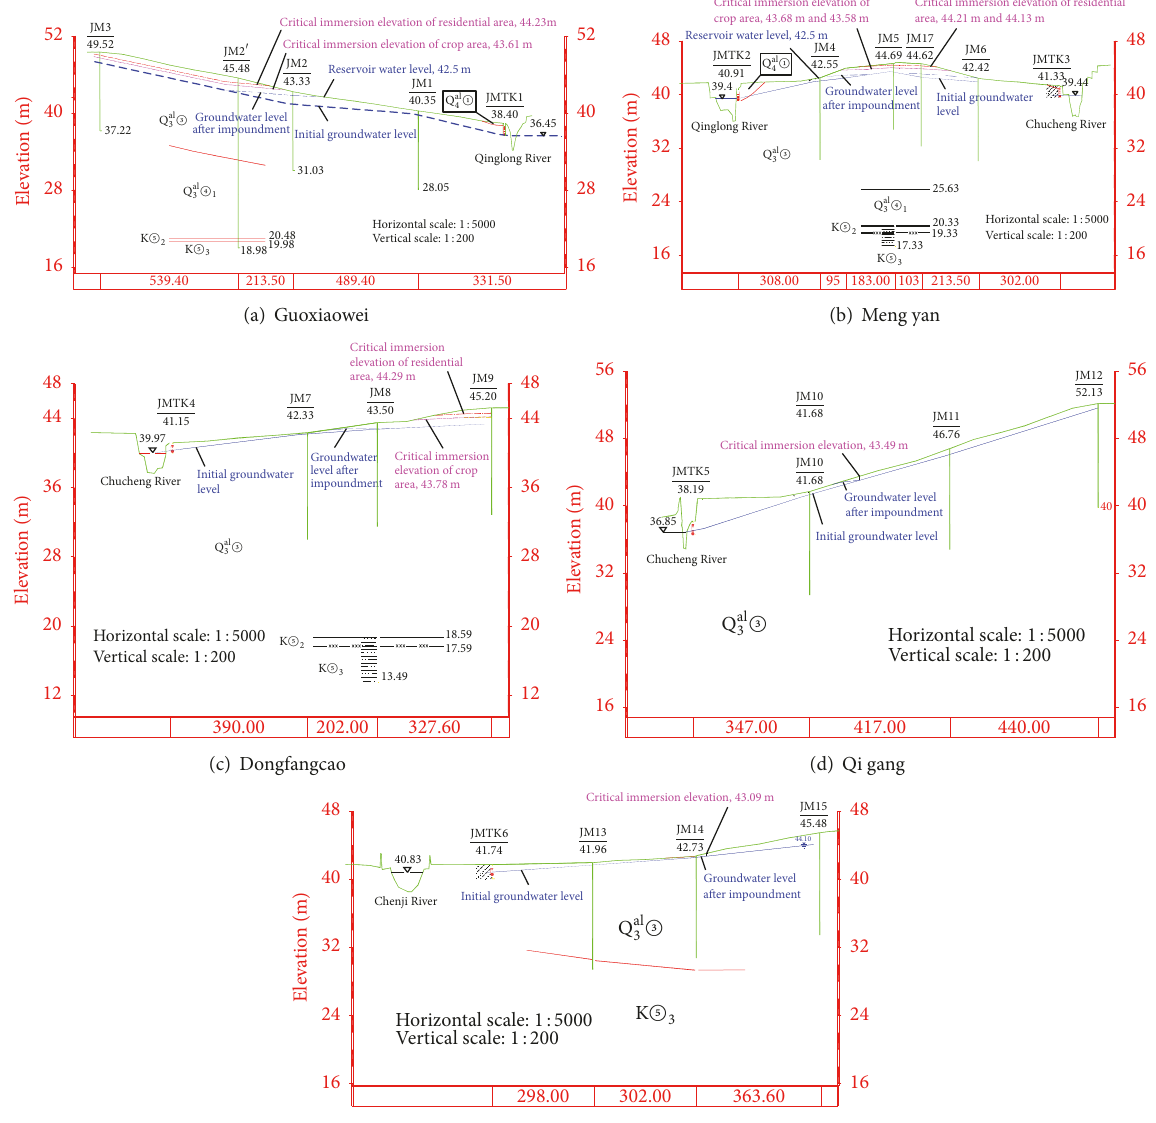
Figure 8: Profiles of zone of immersion influence at a normal water level of 42.5 m.